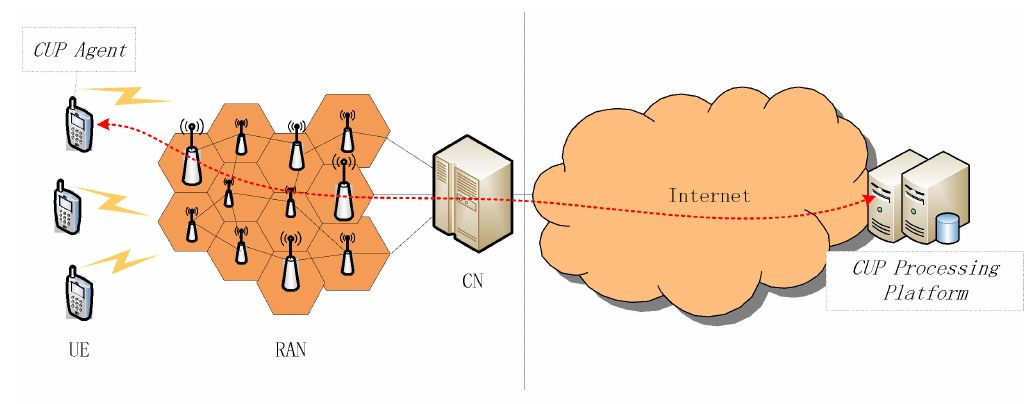
Figure 4. Architecture of the crowdsourcing-based user perception